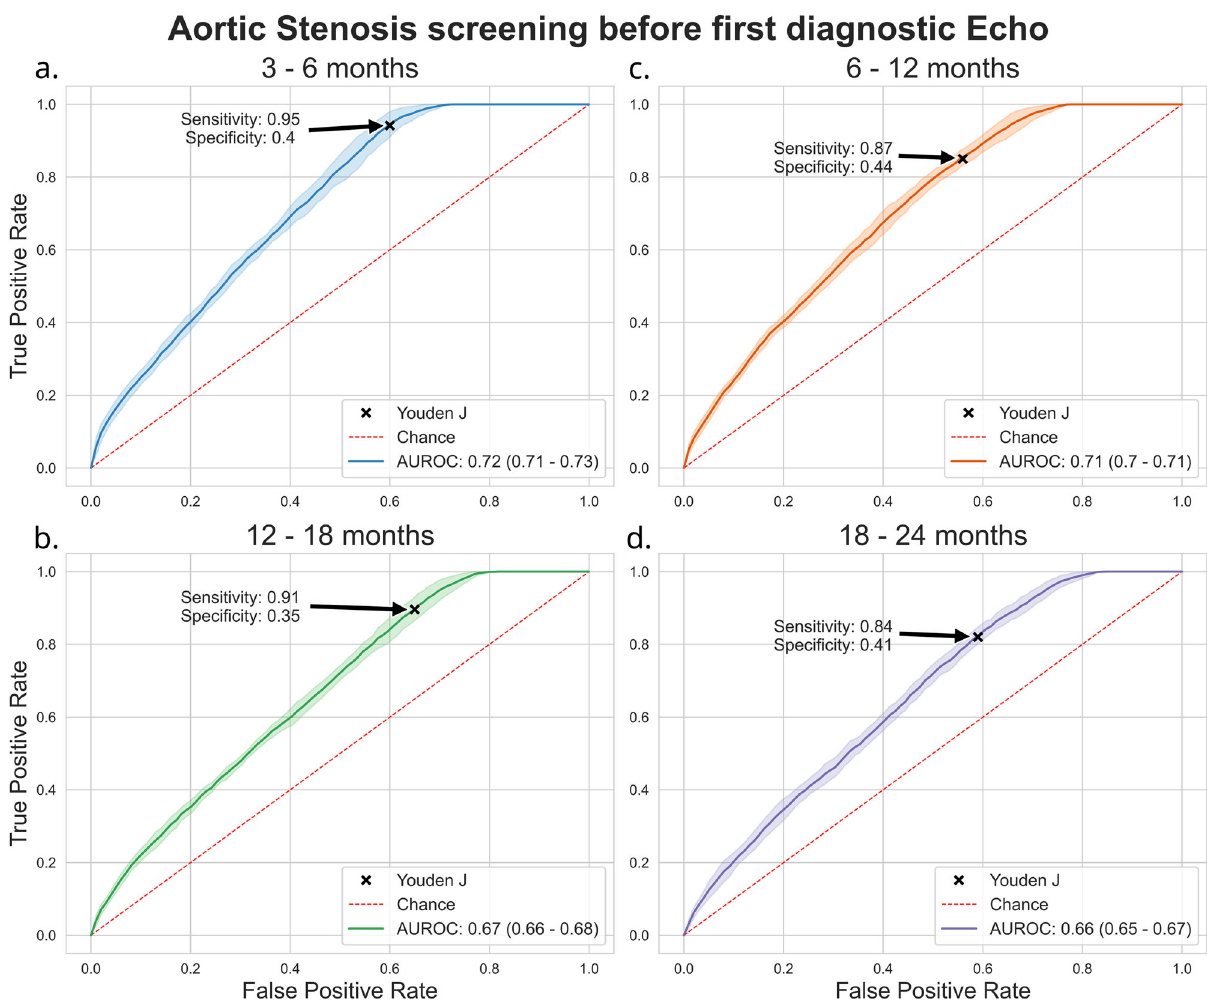
Fig. 7 Model performance at detection of Aortic Stenosis prior to diagnostic echo. Shaded area around curve represents con fi dence interval. Highlighted points on each curve demonstrate optimal sensitivity and speci fi city as derived by the Youden J. Panel a n = 2062 patients (3 – 6 months), Panel c 2096 patients (6 – 12 months), Panel b 2076 patients (12 – 18 months) and Panel d 2058 patients (18 – 24 months) AUROC: Area Under Receiver Operating Characteristic